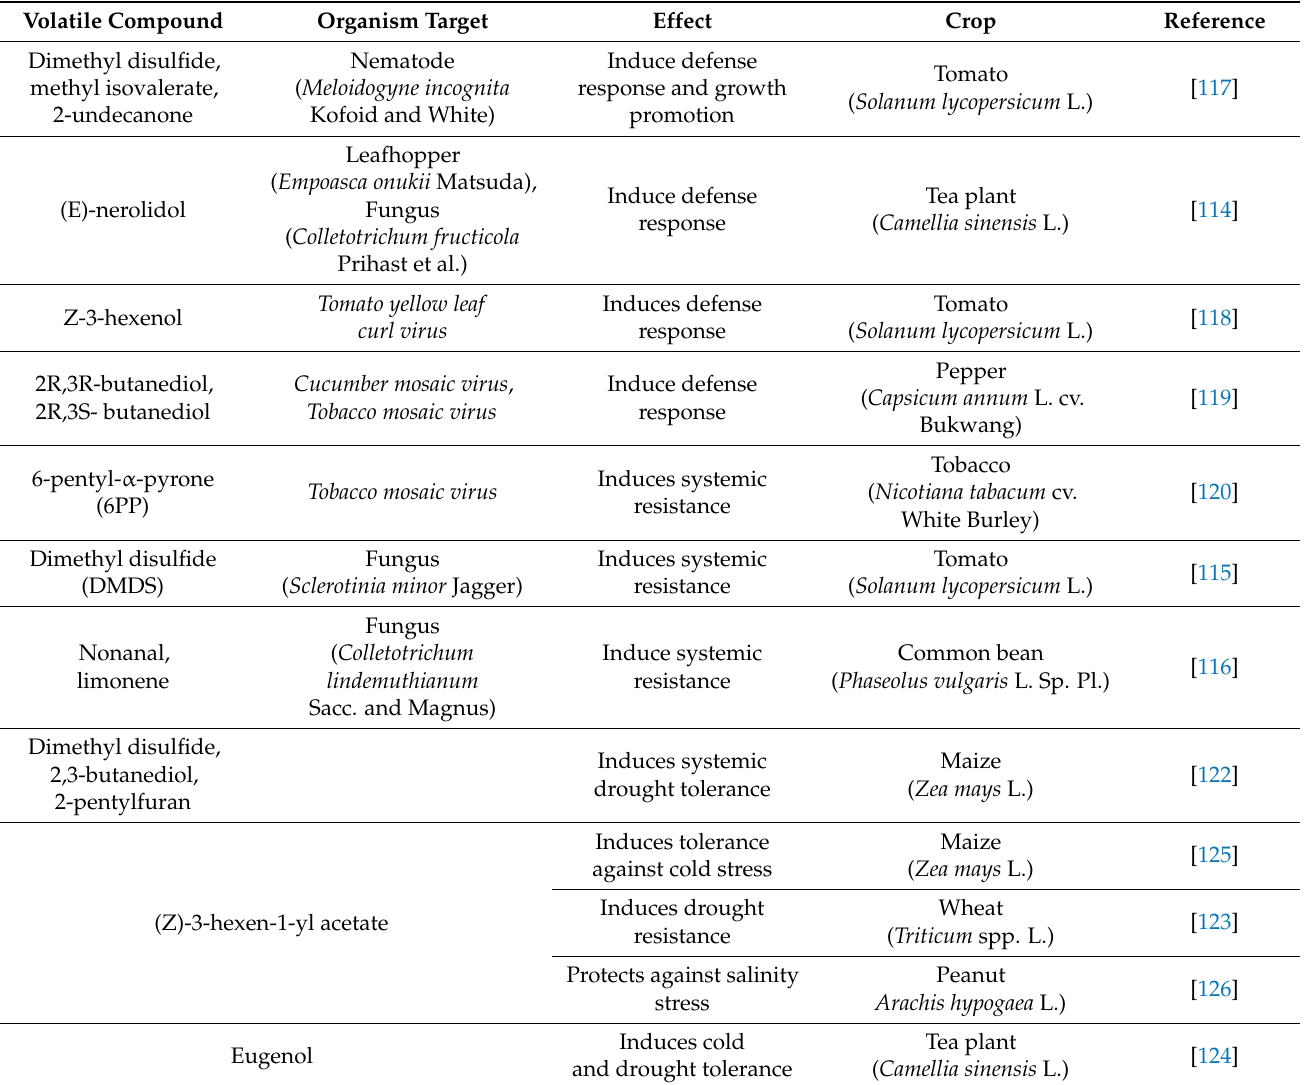
Table 3. Volatile organic compounds with application in biocontrol against biotic and abiotic